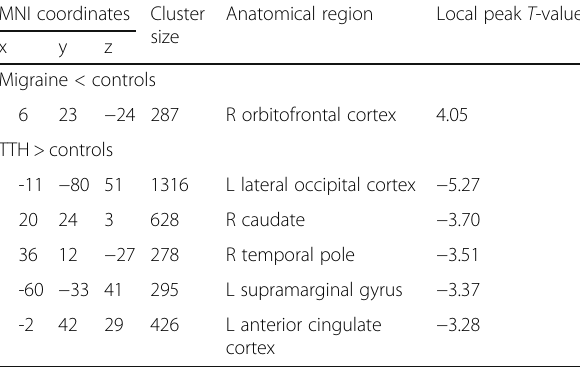
Abbreviations : L left, MNI the Montreal Neurological Institute, R right, TTH tension-type